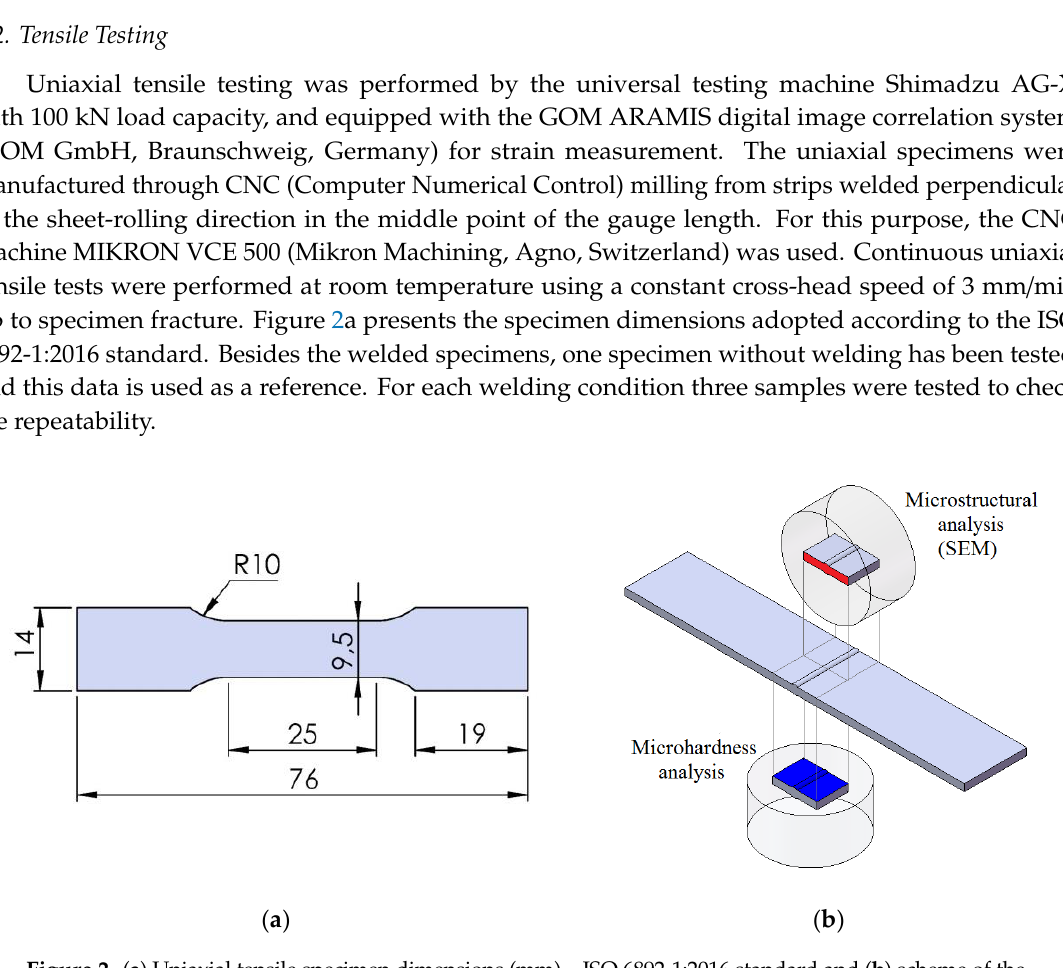
Figure 2. ( a ) Uniaxial tensile specimen dimensions (mm)—ISO 6892-1:2016 standard and ( b ) scheme of the sectioned region of the samples for microstructural (red area) and micro-hardness analysis (blue area).